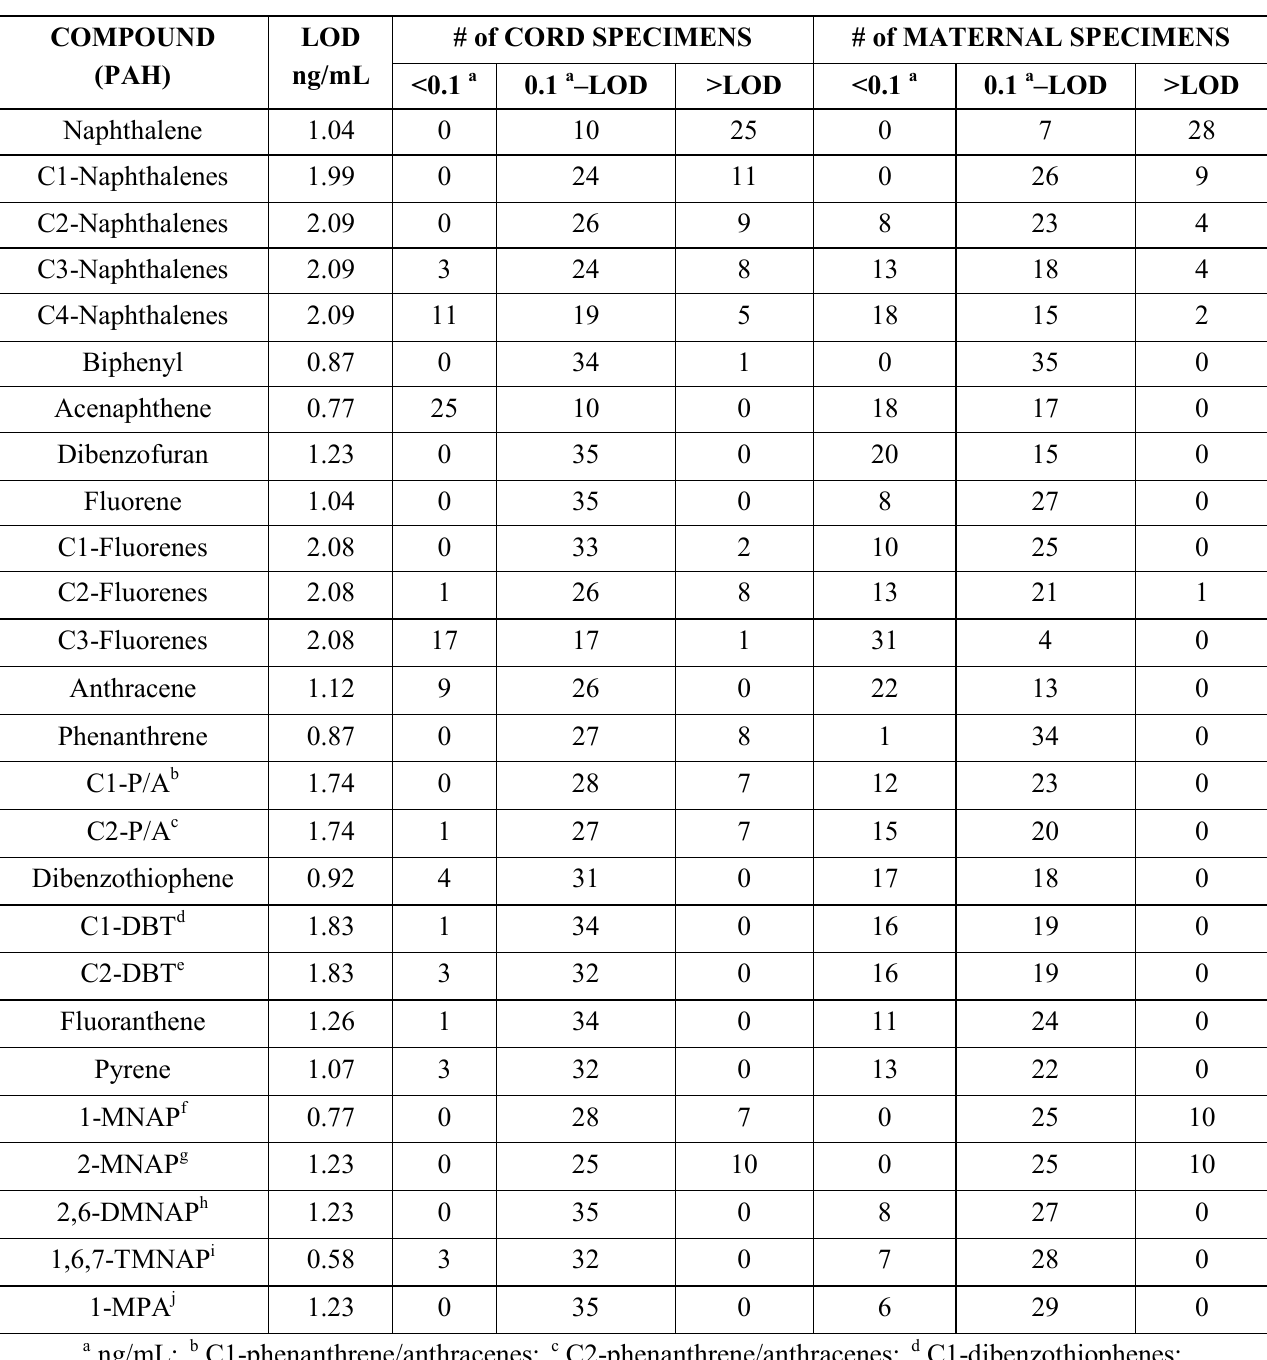
Table A3. Limits of Detection (LOD) and Number of Cord and Maternal Blood Specimens (a) less than 0.1 ng/mL, (b) between 0.1 ng/mL and the Limit of Detection, and (c) greater than the Limit of Detection for 26 Compounds included in the Statistical Analysis (N = 35 matched sample